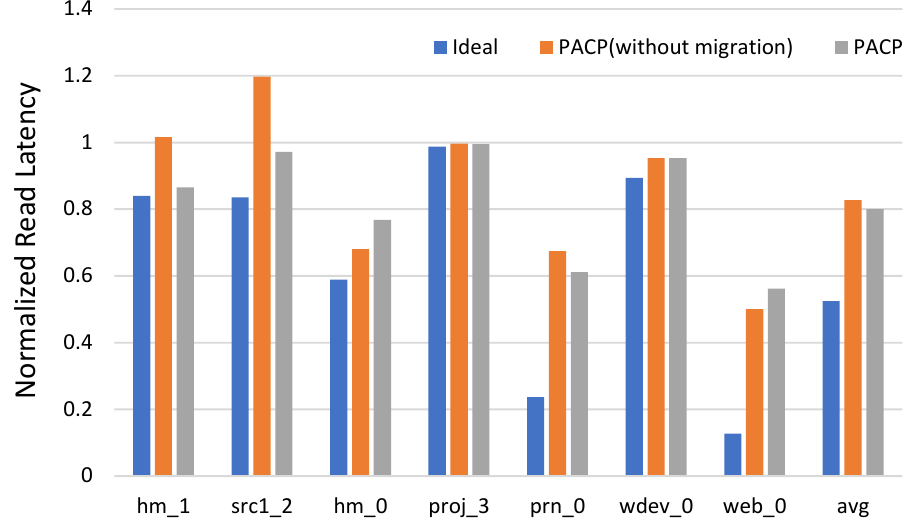
Figure 7. Normalized read latency comparison with the